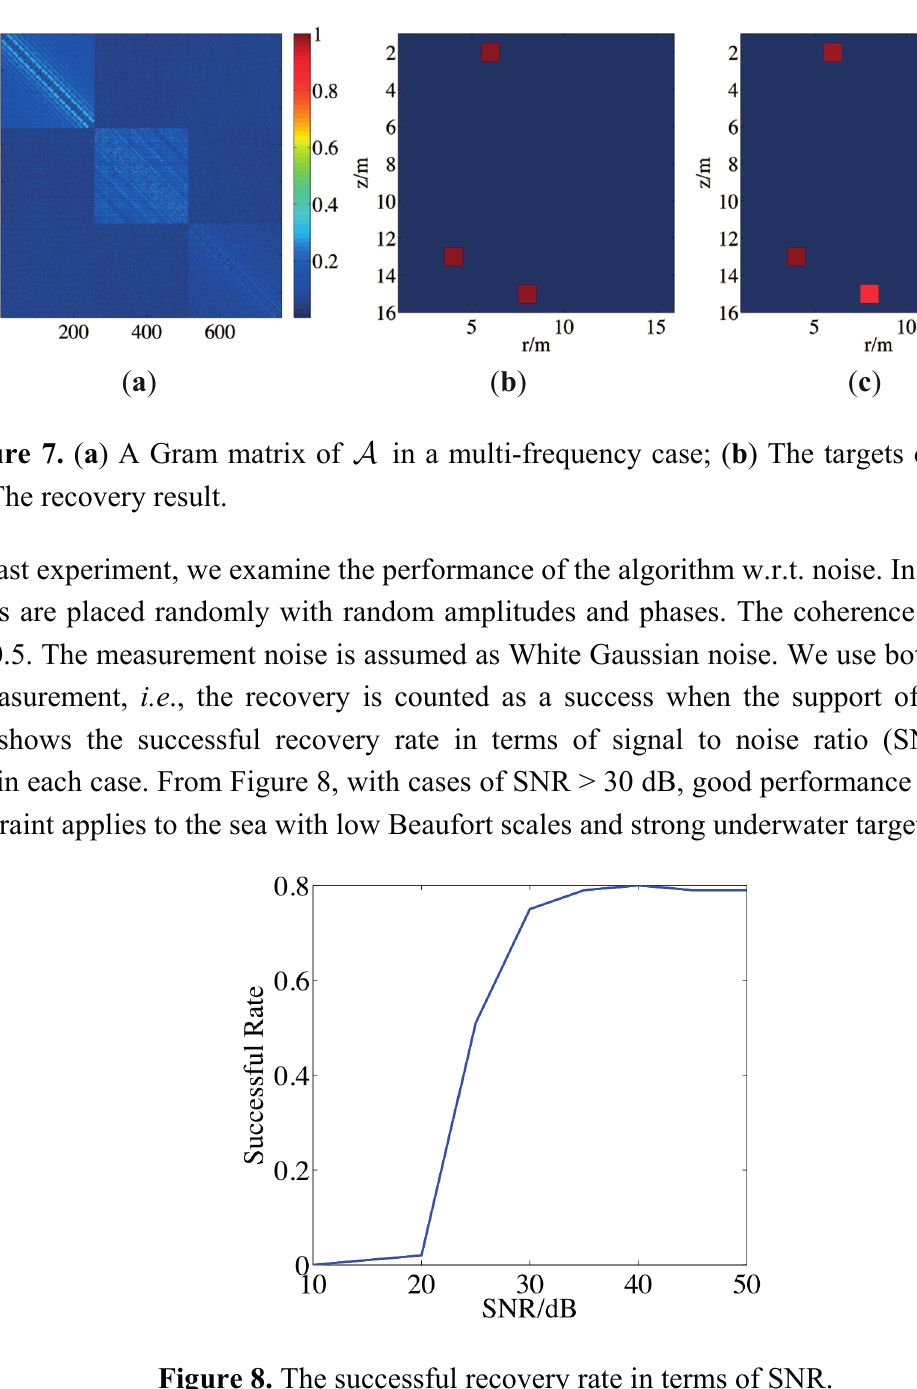
Figure 8. The successful recovery rate in terms of